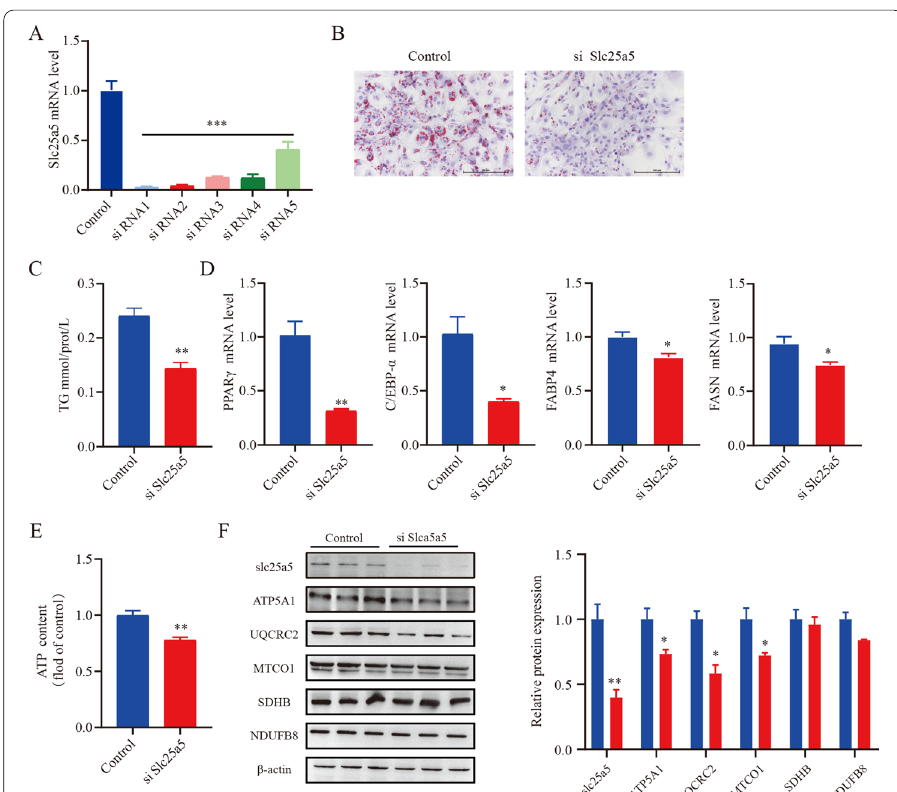
Fig. 2 Inhibiting Slc25a5 prevents adipogenic differentiation. Before adipogenic differentiation, OP9 cells were transfected with Slc25a5 siRNA, and 24 h later, the cells were incubated with 1 mM rosiglitazone to induce adipogenic differentiation. A RT–qPCR verified the efficiency of Slc25a5 knockdown in OP9 cells. B Oil Red O staining; scale bar is 200 μm. C Cellular TG levels were measured. D RT–qPCR was performed to assess the expression of the adipogenic factors PPARγ, FABP4, FASN, and C/EBPα. E Western blot of selected subunits of the OXPHOS complexes. F Cellular levels of ATP. Values are the mean versus